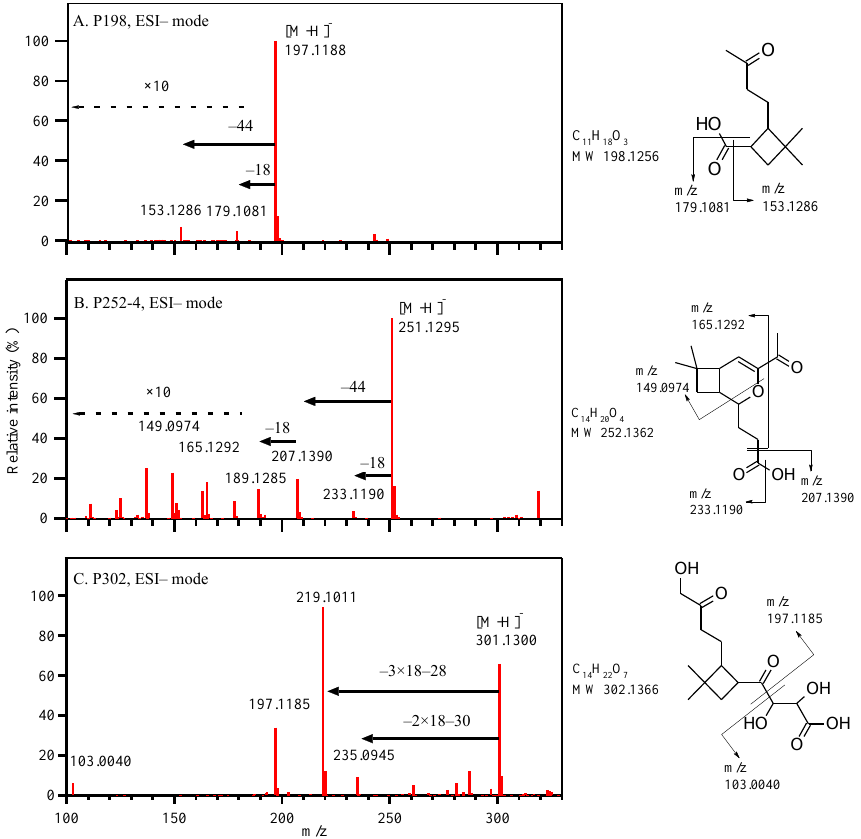
Fig. 3. Fragmentation mass spectra of particle-phase products not previously identified in the literature, including (A) P198, (B) P252-4, and (C) P302. Fragmentation spectra were obtained by increasing the “aperture 1” voltage of the ToF-MS from 5 to 25V (Table S3), inducing in-source collision and dissociation. Fragmentation achieved in this way is comparable to that obtained by tandem-in-space techniques such as a triple quadrupole analyzer (Gerssen et al., 2008) and provides additional information for structural elucidation. Proposed structure and fragmentation points are shown to the right of each panel. Solid arrows in the main figures indicate the fragmentation pathways that yield the observed ion peaks. Loss of H 2 O is indicated by − 18, and loss of CO 2 corresponds to − 44. Dashed arrows indicate regions in which the signal intensities are multiplied by a factor of